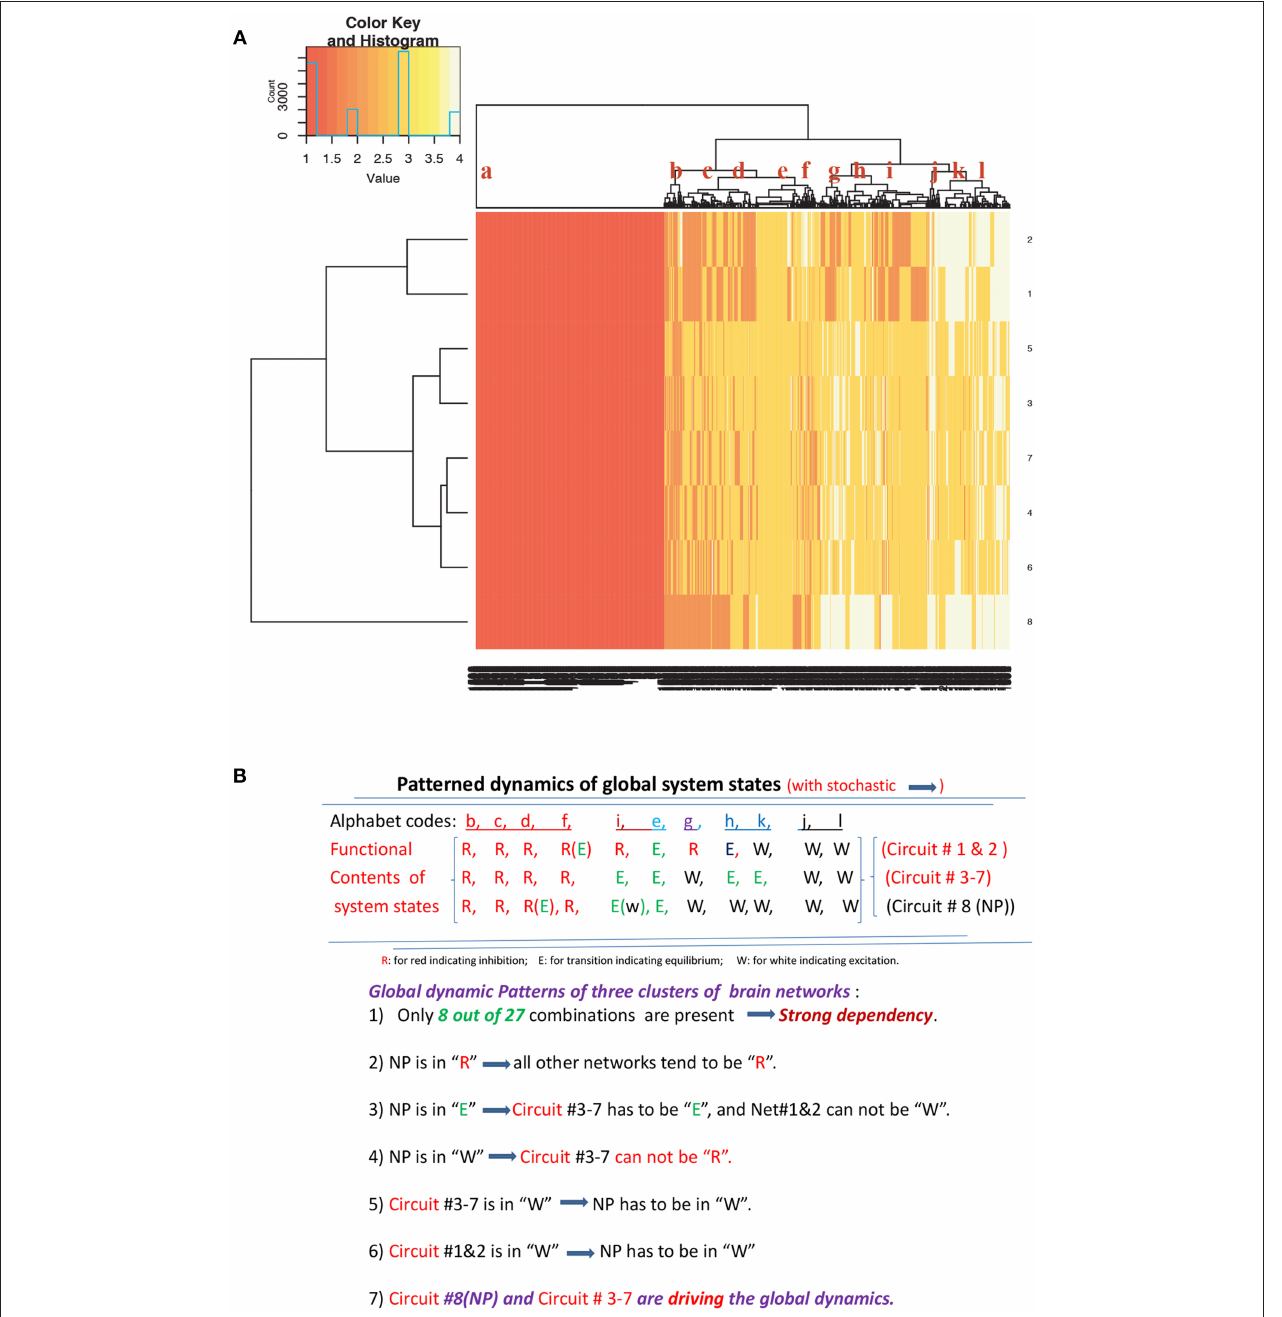
FIGURE 5 | Global patterned-dependency: (A) identification of global system-states upon the 8 communities (the 8th one the 696 pixels from neuropil); (B) summary of functional dependency among 8 communities and its driving force of the 8th